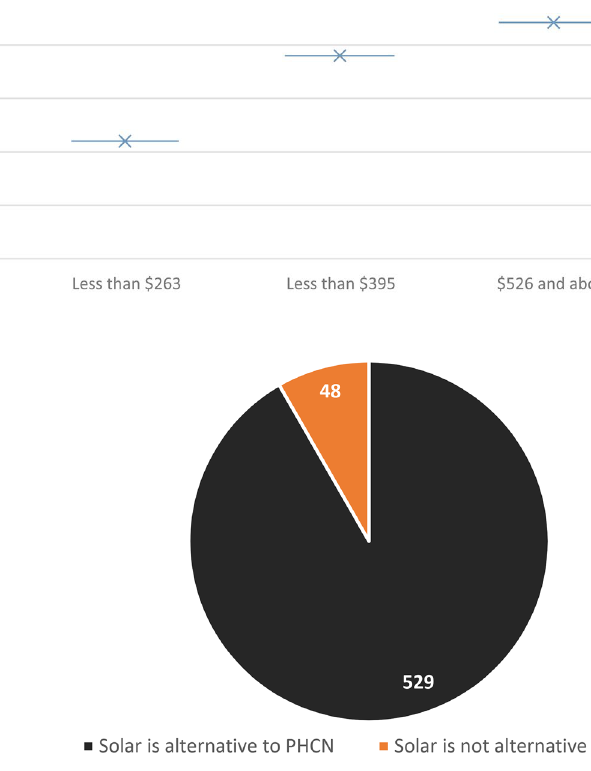
Fig. 3 Estimated Monthly Profit of Respondents’ Profit.